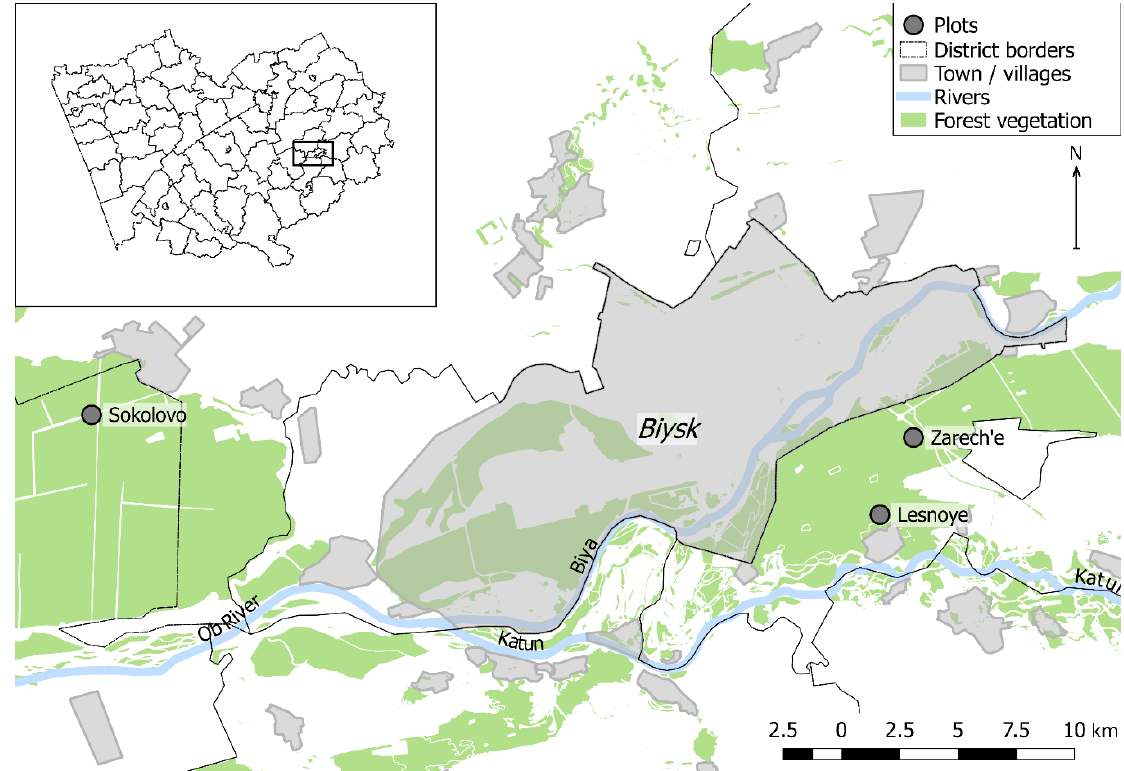
Figure 1. Location of studied forest stands in Altai Krai (insert) and the lower reaches of the Biya River.